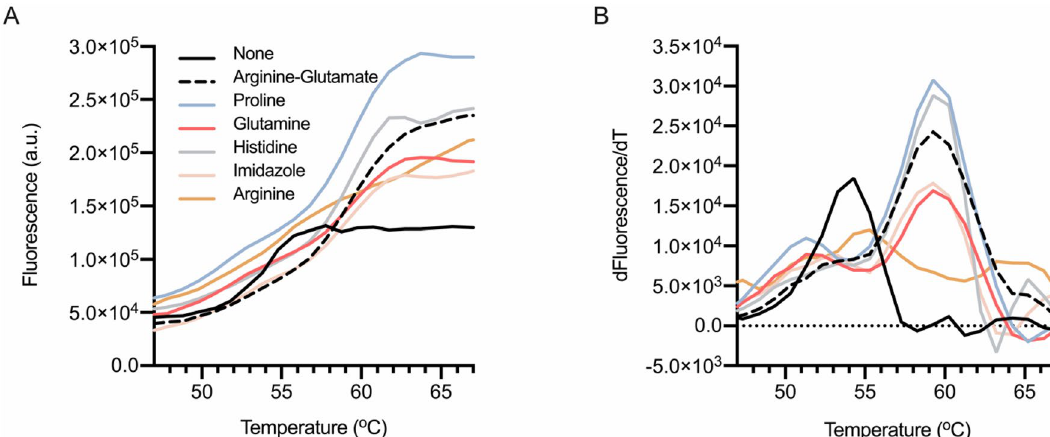
Figure 5. Additives increase the thermal stability of rhOSM in pH 6.6 phosphate buffer. ( A ) Thermal denaturation curves with legend. Curve with sodium phosphate buffer only (None), shown in black; L-arginine and L-glutamate in dashed black; L-proline in sage; L-glutamine in salmon; L-histidine in gray; imidazole in peach; and L-arginine in orange. ( B ) The first derivative of fluorescence emission as a function of temperature.